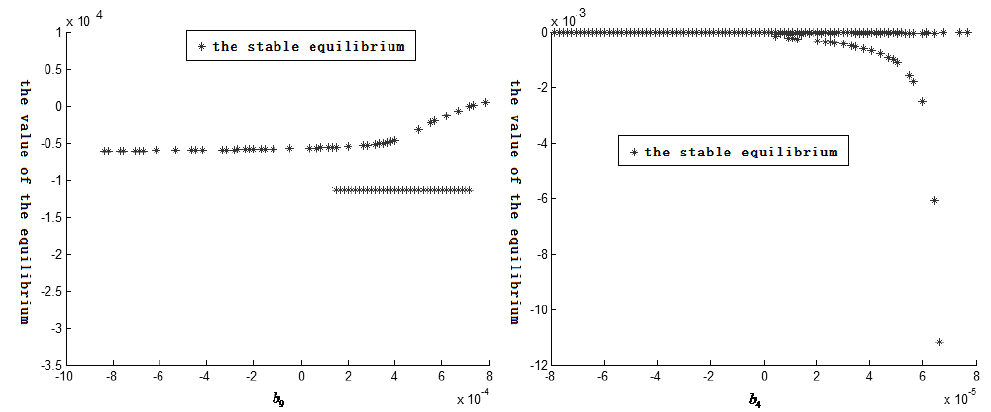
combination with